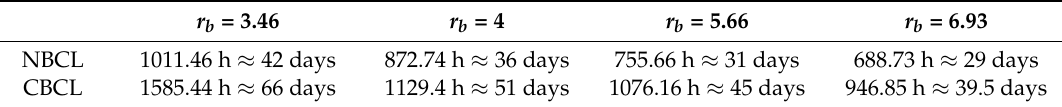
Table 3. Durability comparison between NBCL and CBCL of